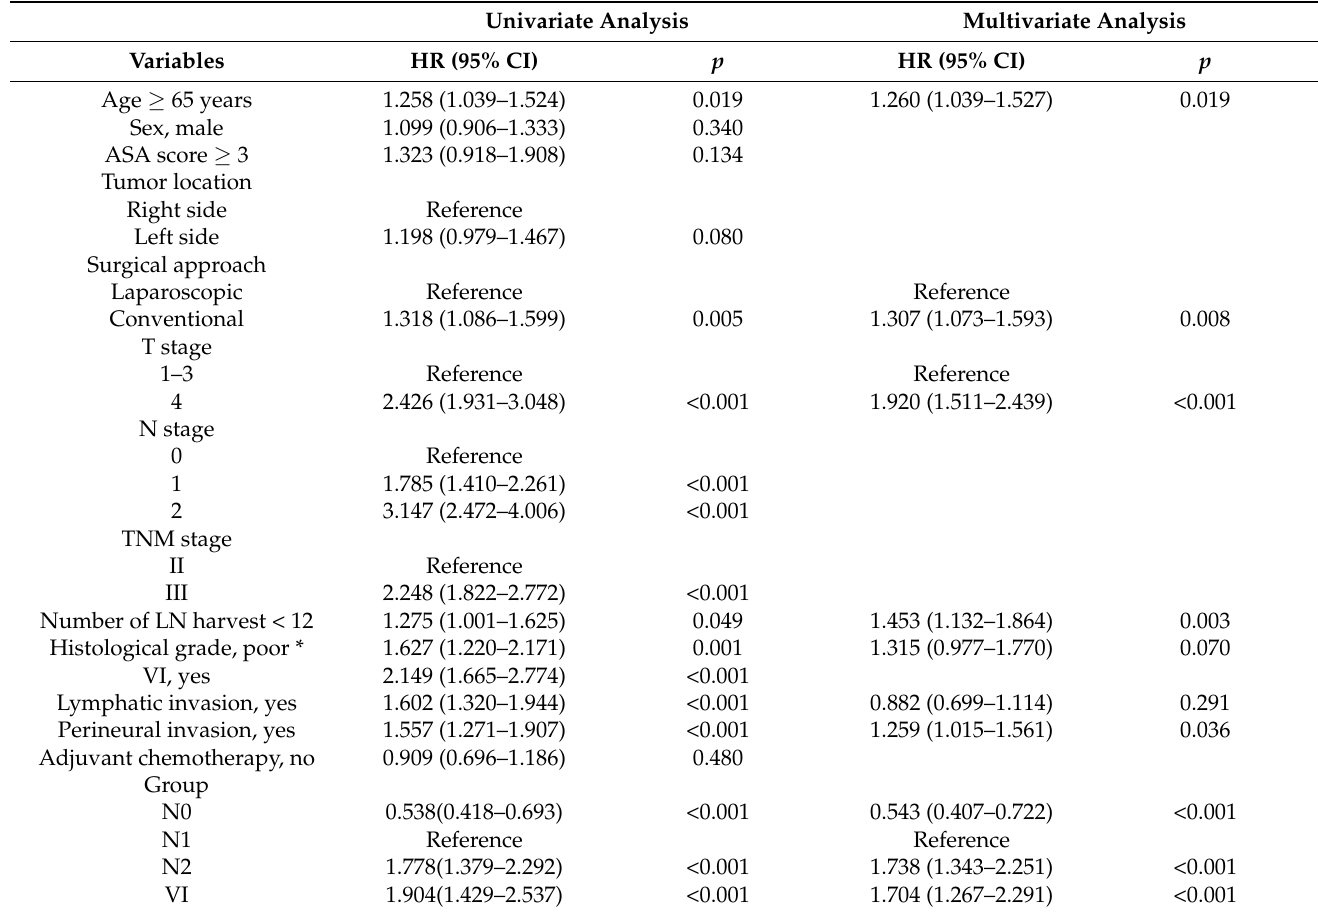
Table 3. Disease-free survival: the univariate and multivariate analyses. Univariate Analysis Multivariate Analysis